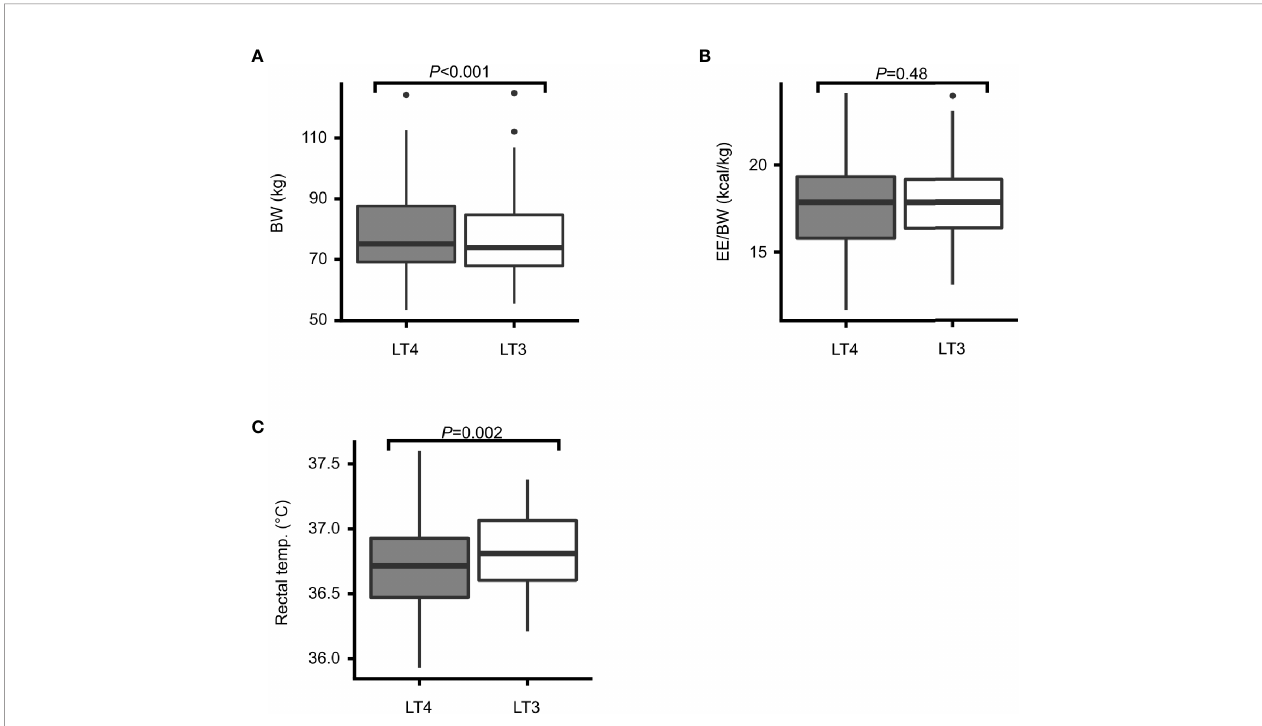
FIGURE 3 | Body weight, energy expenditure and core temperature. Box plots showing treatment effects after 12 weeks treatment with LT4 (grey) and LT3 (white) in terms of: (A) body weight (BW) in kilograms, (B) energy expenditure relative to body weight (EE/BW), and (C) rectal temperature in degrees